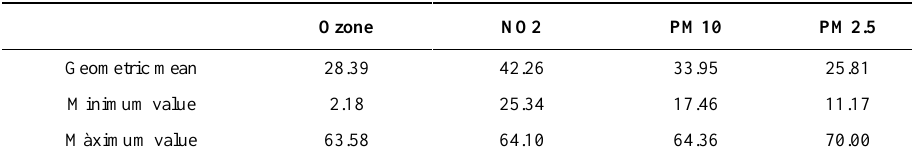
Table 2. Concentrations in  g/m 3 .